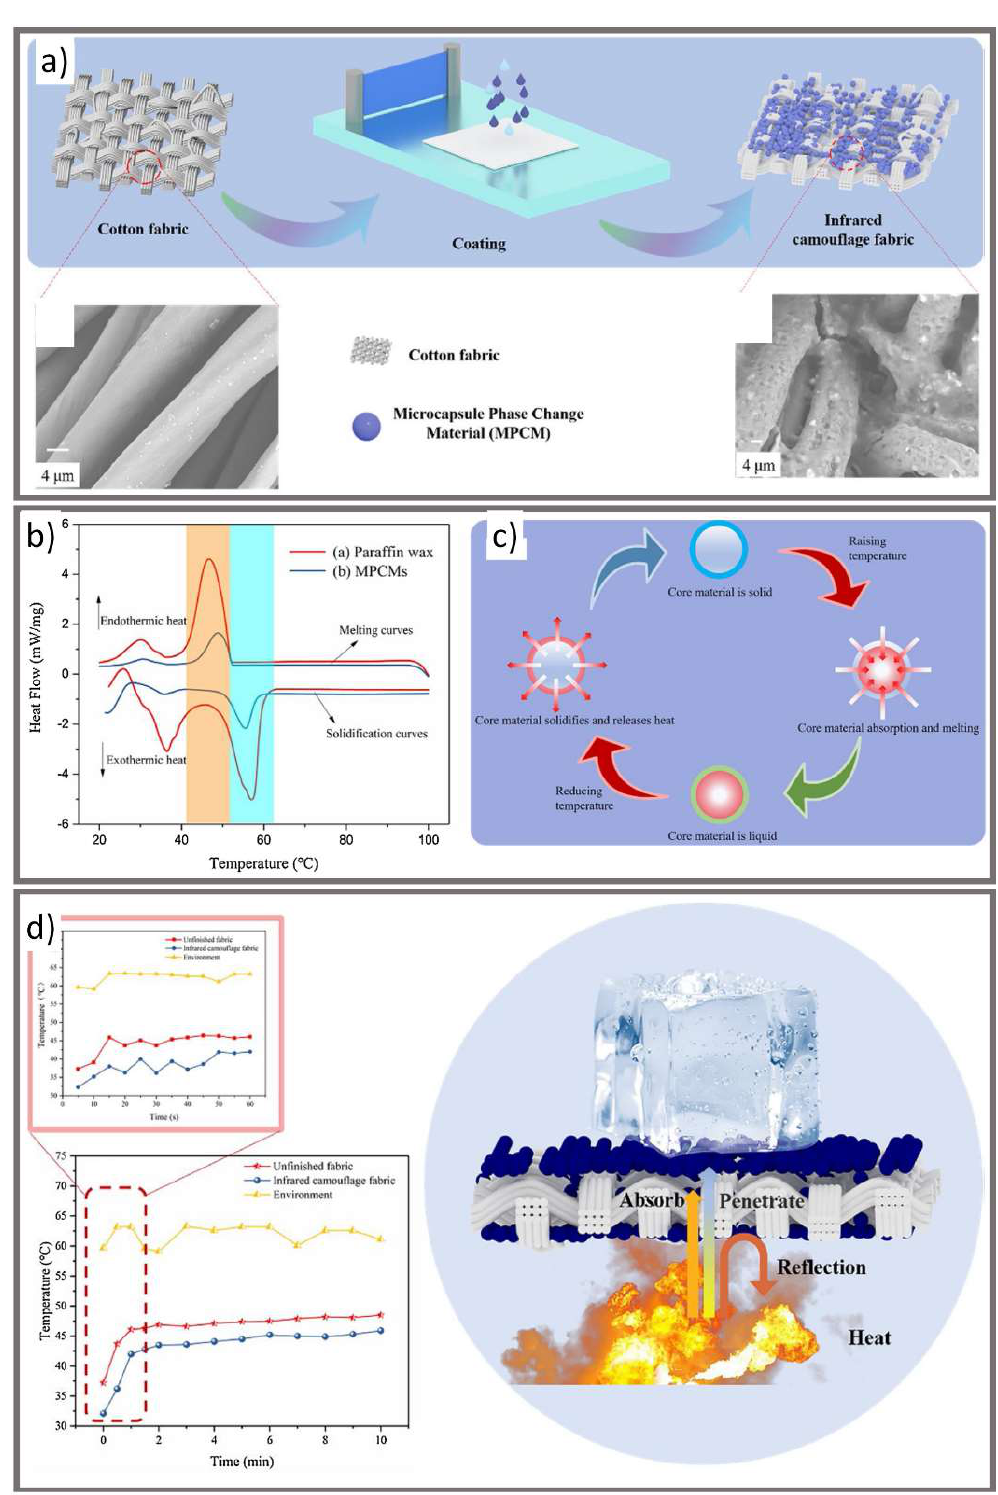
Figure 5. ( a ) Schematic illustration of the fabrication of IR camouflage fabric. ( b ) Differential calorimetry scanner (DSC) curves of microcapsule phase change material (MPCM) and paraffin wax. ( c ) The working principle of MPCMs. When heat is applied to the MPCMs, the core material absorbs the heat and thus melts and, when it cools again, it releases the heat and solidifies. ( d ) Temperature test curve of the unfinished versus IR camouflage fabric at 60 °C (left) and an image demonstrating the IR fabric’s temperature resistance (right) (reprinted from [44], with permission from Elsevier).